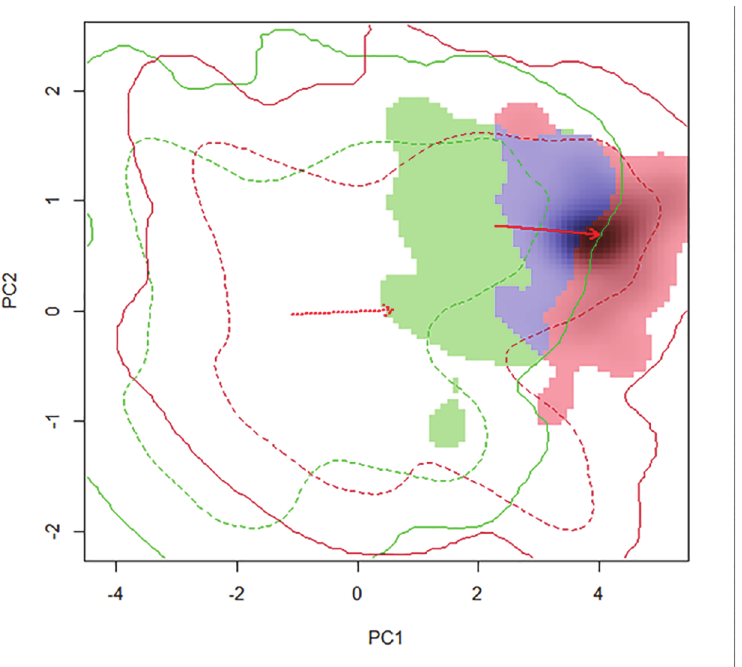
Fig 4. Principle component analysis (PCA) of niche overlap (blue) for B . tectorum in Rocky Mountain National Park based on current (green) and future (red) climate space. Averages for five climatic variables from six global circulation models (GCMs) were included in this analysis: mean annual temperature, spring degree days below 18°C, beginning of frost-free period, mean summer (May-Sept.) precipitation, and continentality (see methods for description of